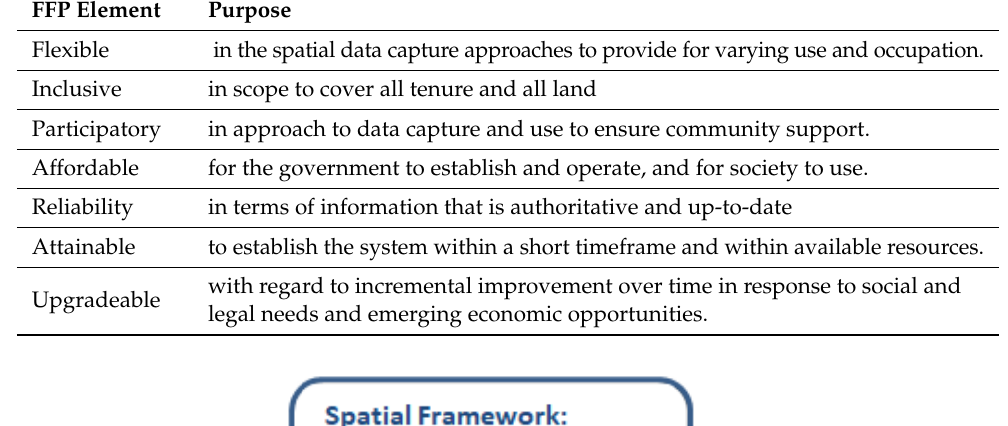
Table 2. Elements of the FFPLA approach [15].